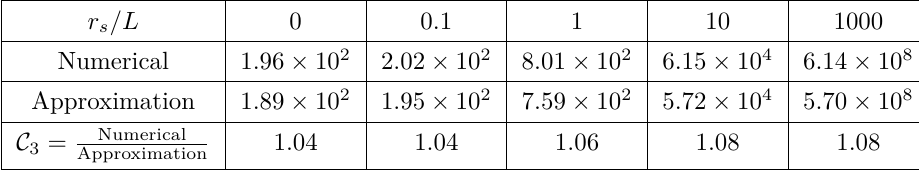
Table 3 . d = 3 and δr/r s = 10 − 4 .